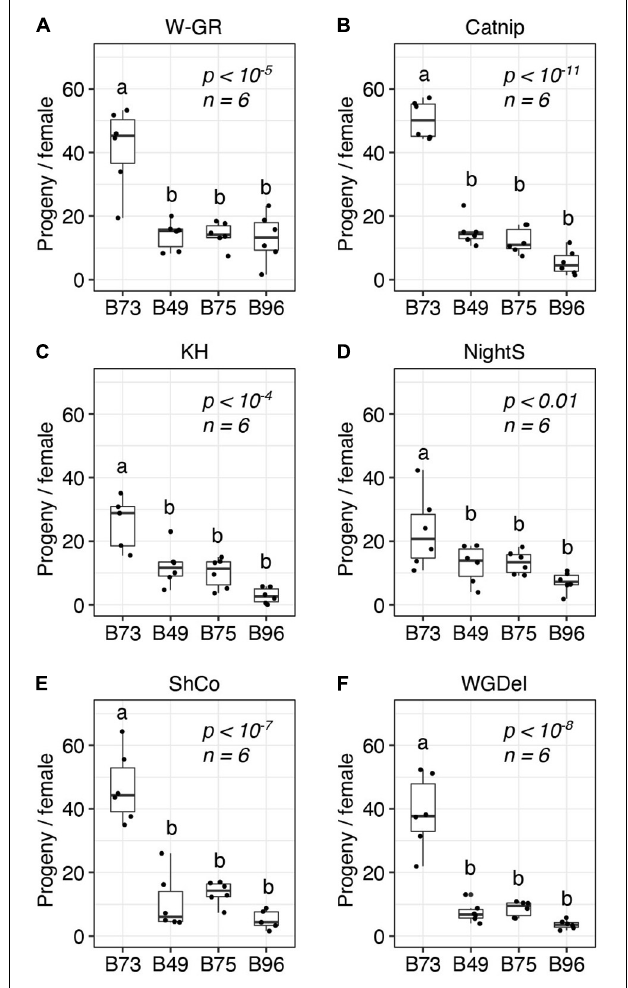
FIGURE 3 | B49, B75, and B96 are resistant to multiple strains of T. urticae . The number of progeny per adult T. urticae female after 6 days of feeding is given for each of six unrelated T. urticae strains for each of four maize lines (A–F) (boxplots with overlay of data points are shown; each plot is titled by the name of the T. urticae strain tested). Assays were performed on the 8th leaves of maize plants. Where significant variation was observed by ANOVA by mite strain ( p < 0.05), pairwise significance was assessed with correction for multiple testing using the Hochberg method (different letters denote significant differences at p < 0.05). Sample size ( n ) is as indicated, except for the B73/KH (C) and B96/ShCo (E) comparisons for which one less enclosure was successfully established ( n =